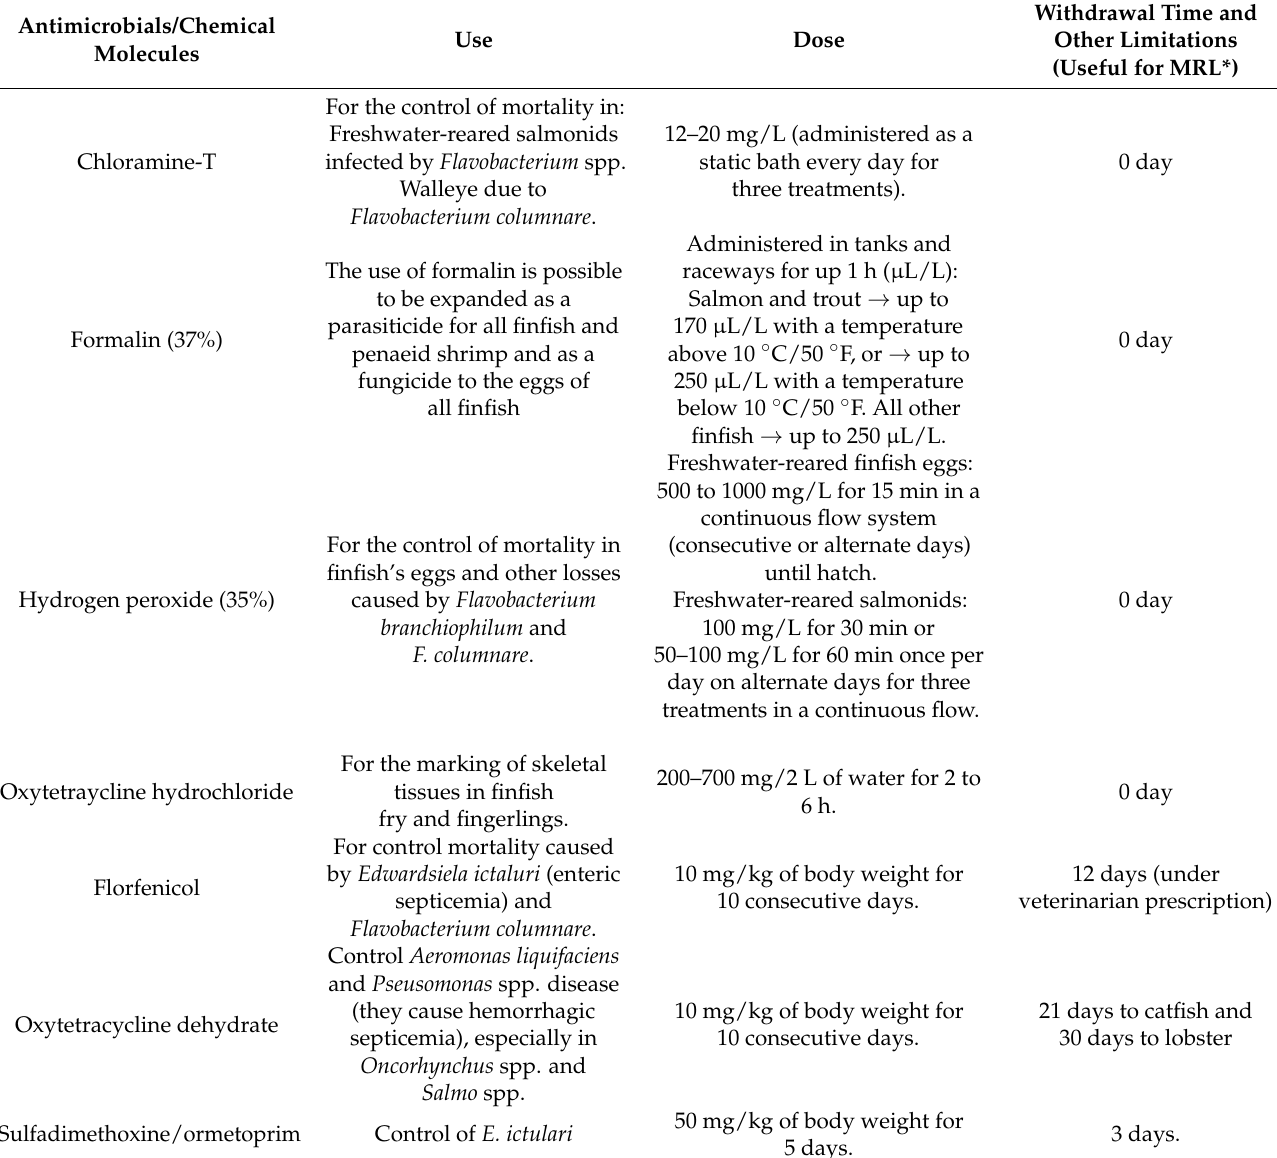
Table 2. FDA-approved aquaculture